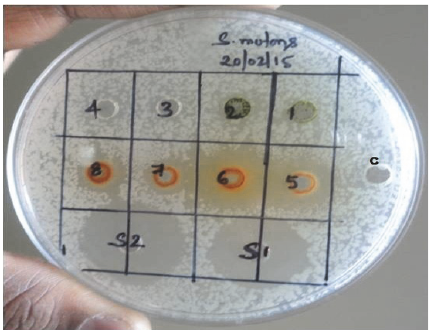
Figure1:Inhibitoryactivityoftestsampleson Streptococcusmutans .